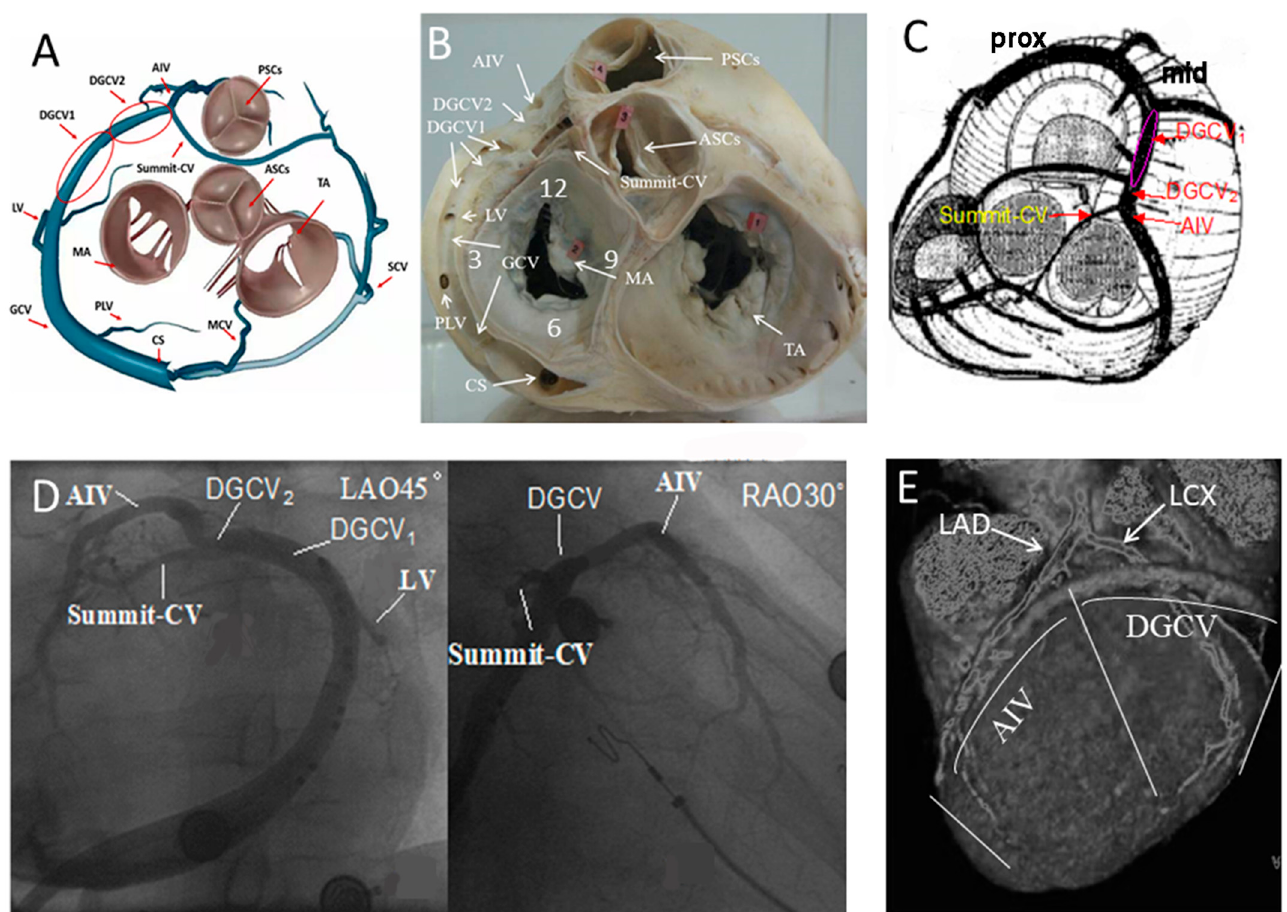
Figure 2. The architecture of the coronary venous system (CVS). ( A , C ), schematic view of the CVS; ( B ), posterior-anterior view of the endocardial and epicardial mitral annulus; ( D ), coronary venography allows clear visualization of the coronary venous architecture; ( E ), CT angiography of the anterior wall of the heart shows the anatomical relationship to the left anterior descending coronary artery (LAD) and the left circumflex coronary artery (LCX). Abbreviation: CS, coronary sinus; GCV, great cardiac vein; DGCV 1 , the distal great cardiac vein local in epicardium of the anterior lateral wall of the mitral annulus; DGCV 2 , the distal great cardiac vein proximal to the origin of AIV. MCV, middle cardiac vein; SCV, small cardiac vein; AIV, anterior interventricular vein; Summit-CV, the communicating vein in left ventricular Summit; PLV, Posterior lateral vein; LV, lateral vein; MA, mitral annulus; TA, tricuspid annulus; PSCs; pulmonary sinus cusp; ASC; aortic sinus cusp. RAO = right anterior oblique; LAO = left anterior oblique.